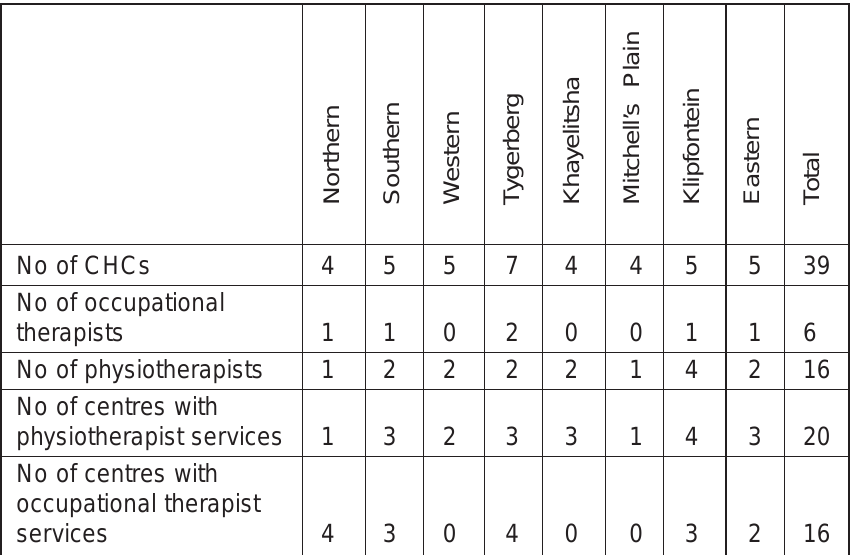
Table.1 Distribution of therapy services per